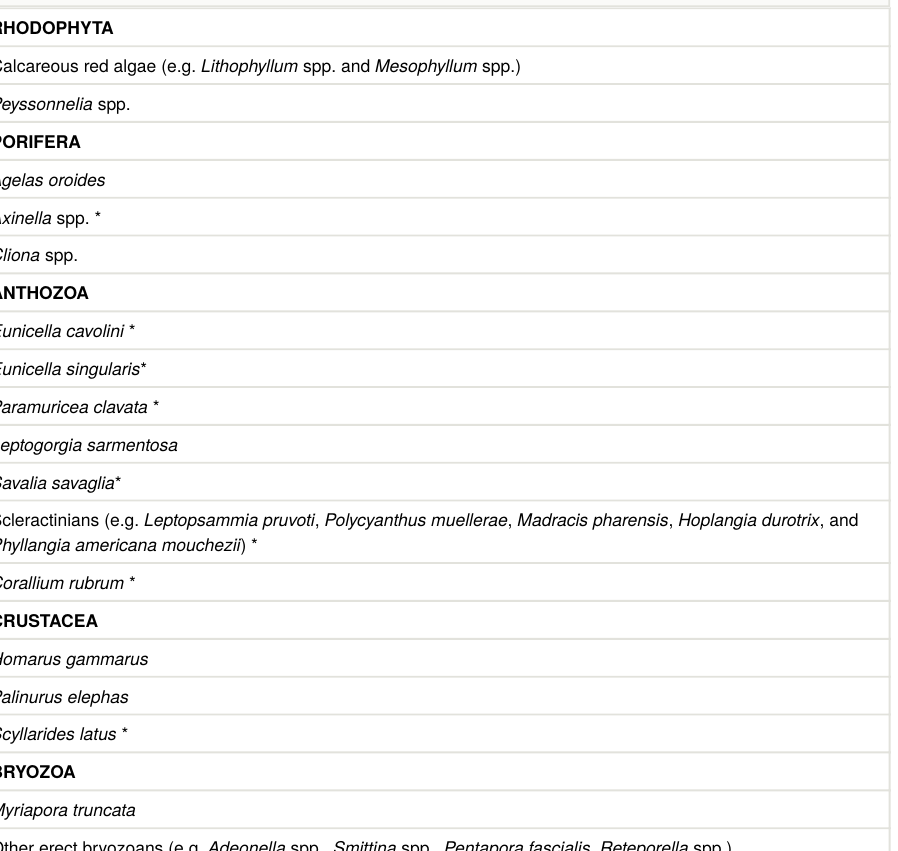
Table 2. List of coralligenous biota examined in the current CS initiative (* protected